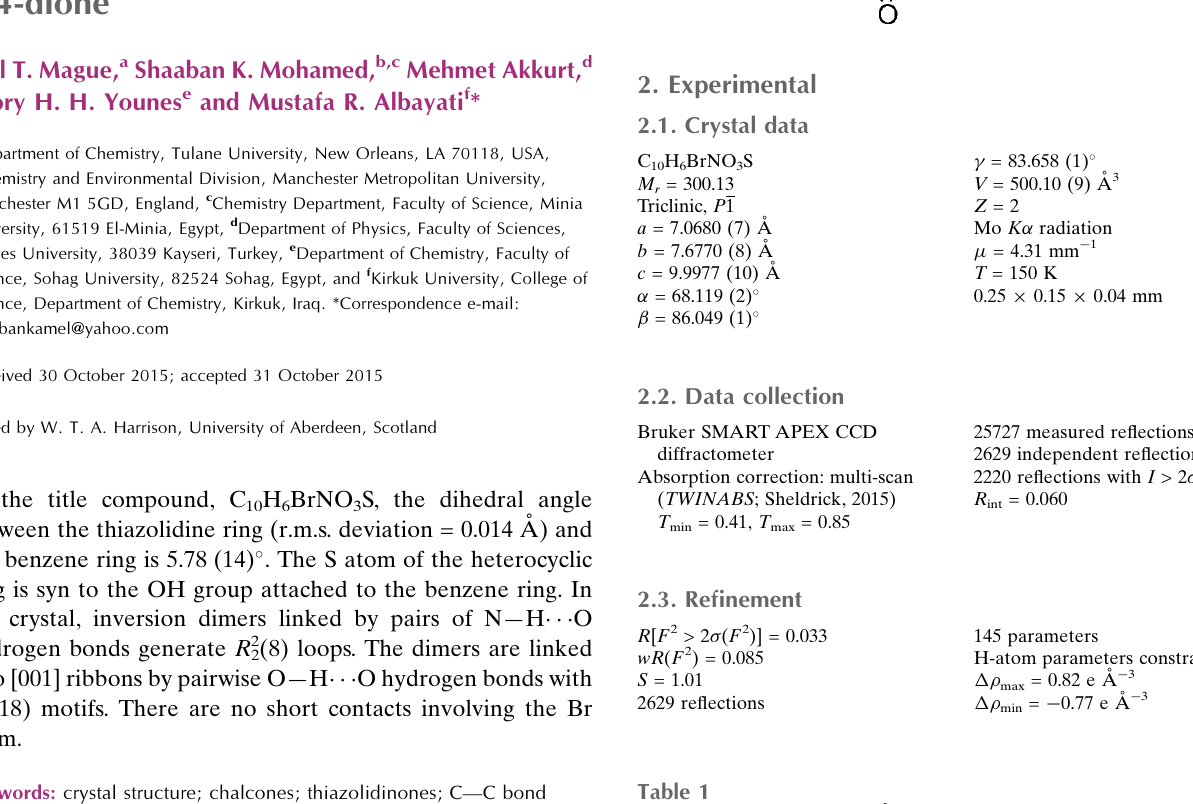
Hydrogen-bond geometry (A˚ , (cid:2)